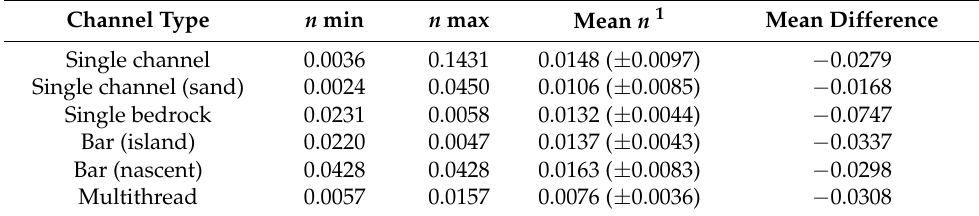
Table 6. Manning’s roughness values ( n ) using Phillips and Ingersoll (1998). Mean difference shows the difference between the Limerinos (1970)-derived average values of channel